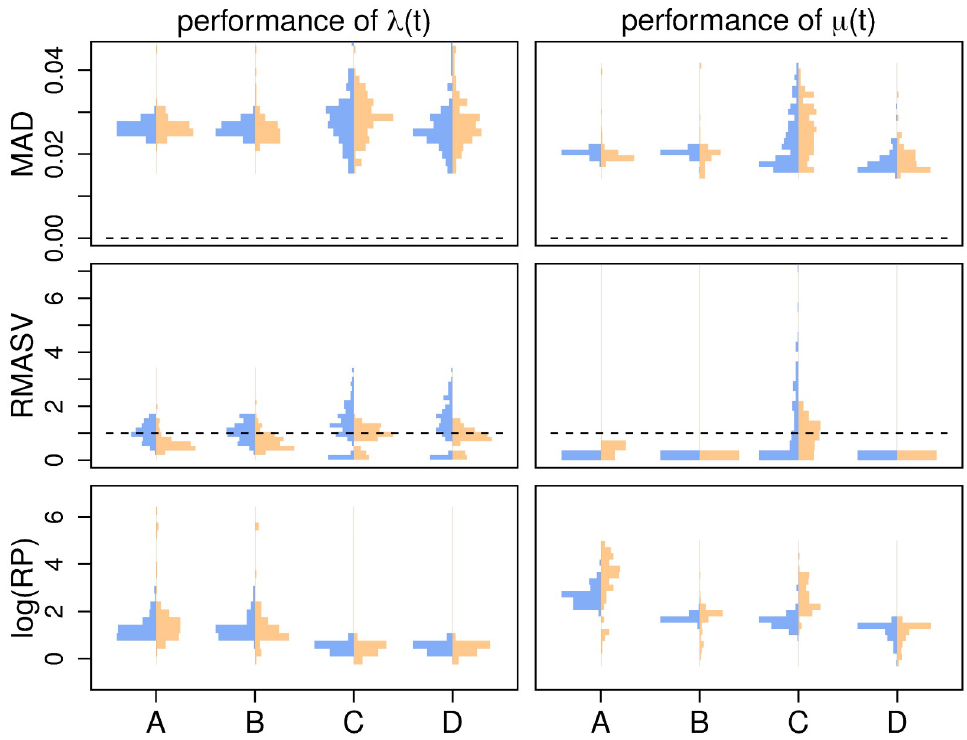
Fig 6. Performance of the models on simulated datasets where both the birth- and death-rate trajectories vary. MAD measures the error in the estimated rate. RP is a measure of precision, the width of the 90% Credible Interval relative to the true rate. RMASV measures the total amount of change relative to the true MASV, horizontal line at 1 for reference. The column labels A, B, C, and D identify the different combinations of tree simulations and analysis setup. A and B are analyses of trees with isochronous sampling, C and D heterochronous sampling. A and C are analyses where time-varying death rate, μ ( t ) is inferred, B and D where a constant death rate, μ , is inferred.